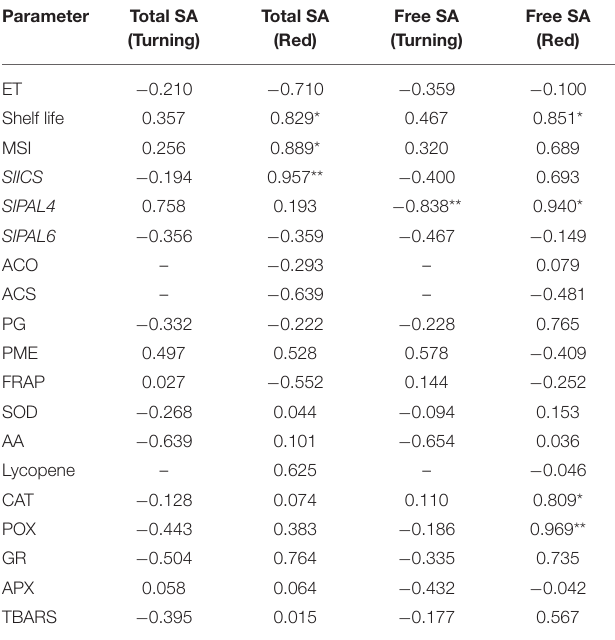
TABLE 3 | Linear correlation between total endogenous SA content and other parameters at turning and red stages of tomato fruit ripening at P < 0.05. Parameter Total SA